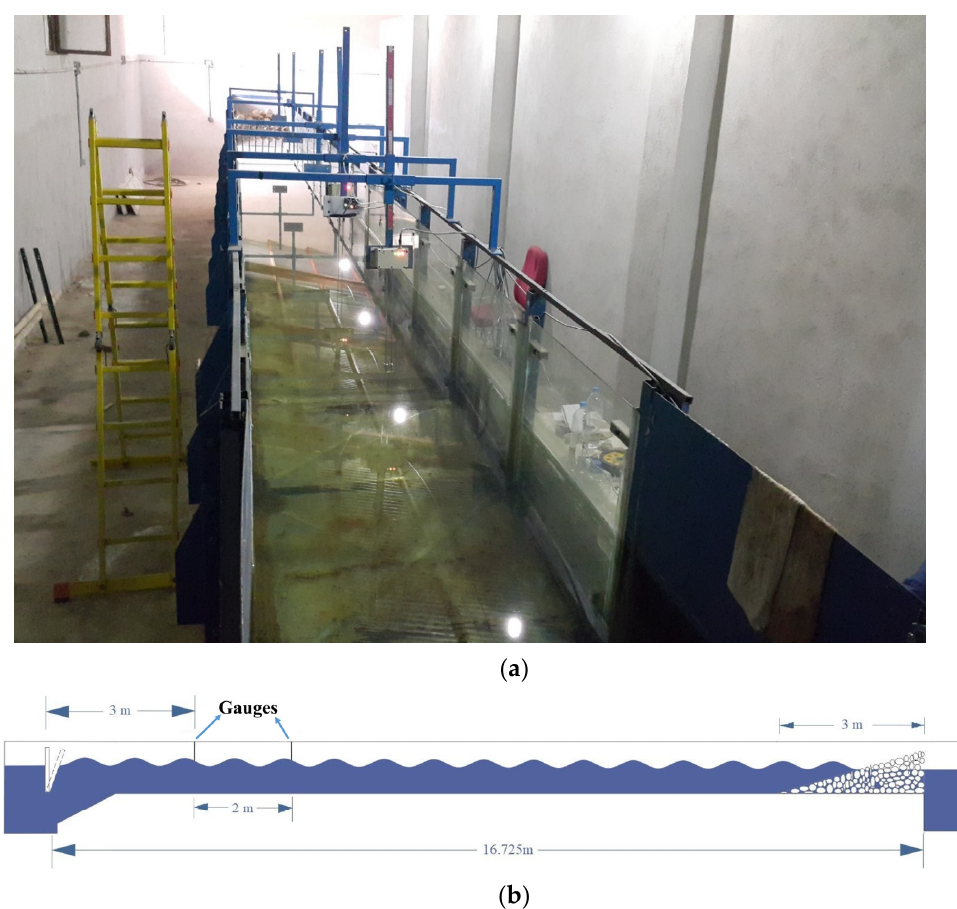
Figure 1. An overview of the experimental wavemaker tank: ( a ) a real picture and ( b ) schematic illustration.